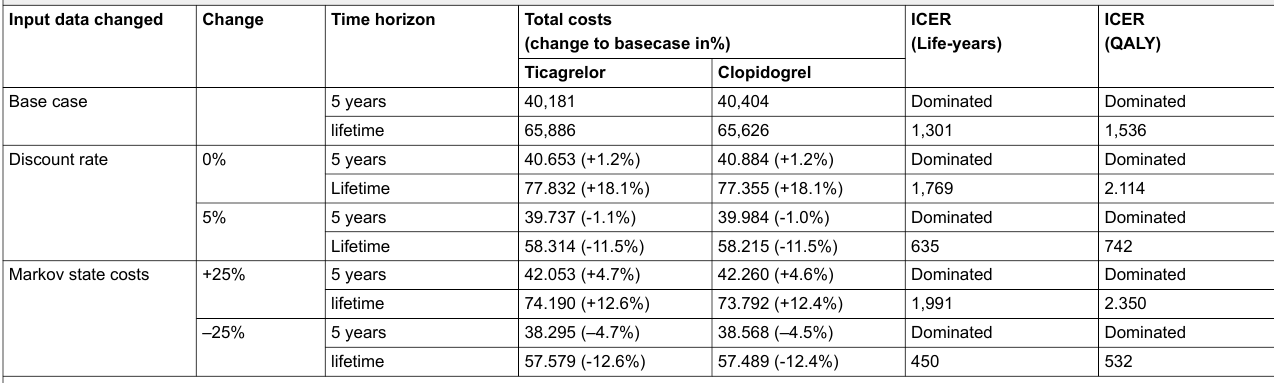
Table 9: Sensitivity analyses for the Markov